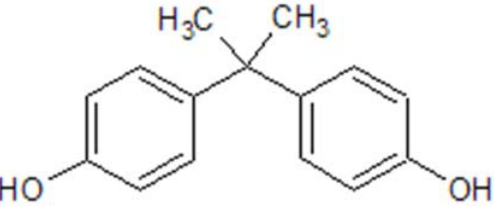
Figure 1. BPA chemical structure, drawn in ChemDraw ®® .